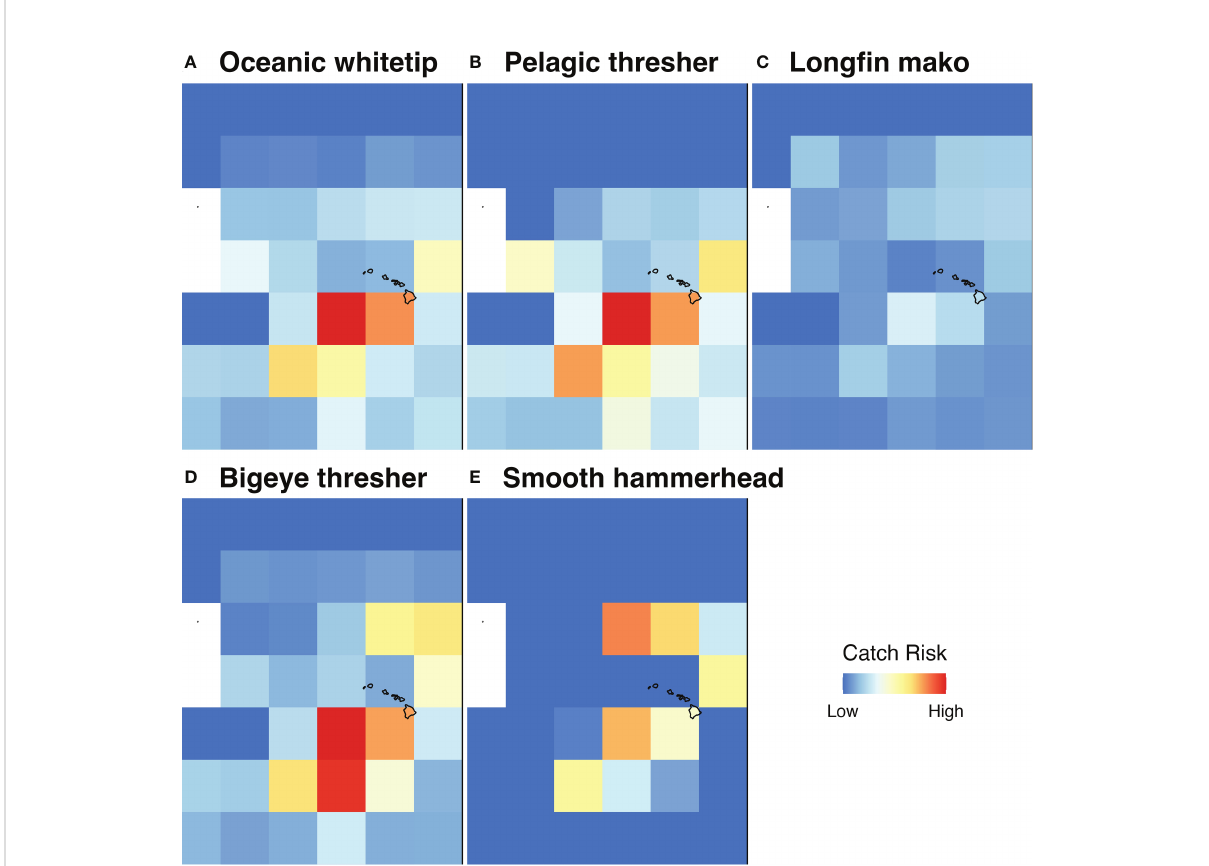
FIGURE 6 Catch risk hotspots for fi ve shark species near the Hawaiian Islands. A closer look at predicted shark interaction risk hotspots near the Hawaiian Islands for species that are considered Critically Endangered (oceanic whitetip; Carcharhinus longimanus [ A ]), Endangered (pelagic thresher; Alopias pelagicus [ B ], long fi n mako; Isurus paucus [ C ]), or Vulnerable (bigeye thresher; Alopias superciliosus [ D ], smooth hammerhead; Sphyrna zygaena [ E ]) by the IUCN. The right plot border represents the Eastern WCPFC